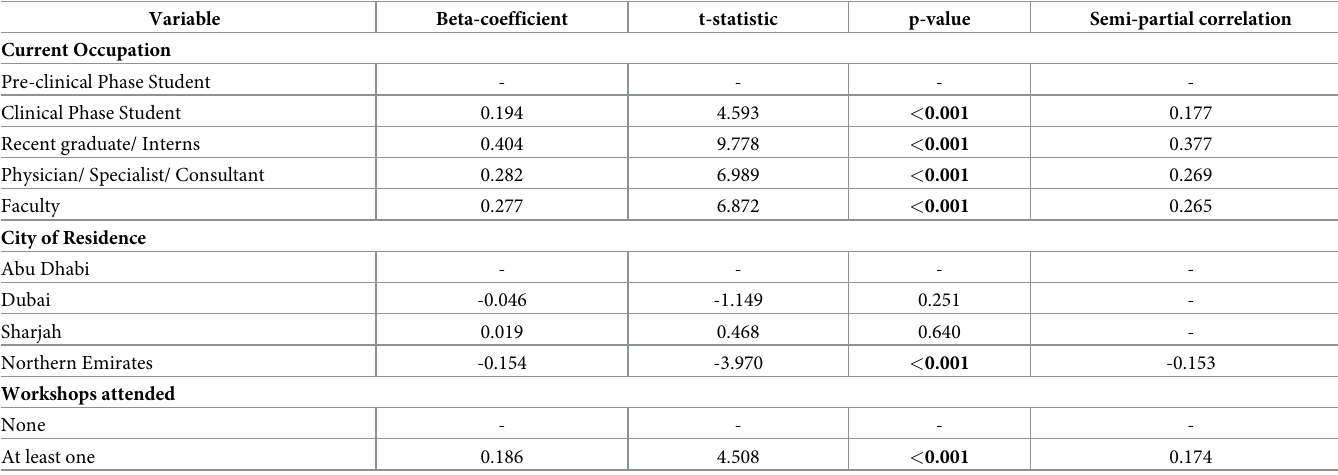
Table 3. Summary of stepwise multiple regression model for knowledge score.